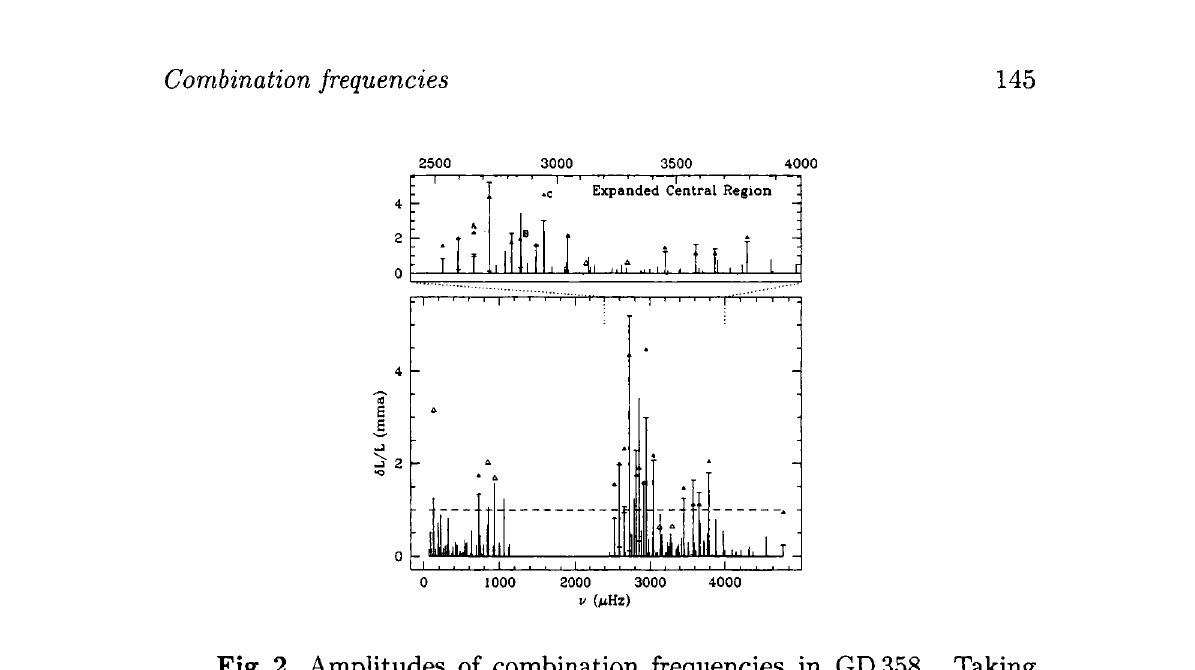
Fig. 2. Amplitudes of combination frequencies in GD 358. Taking amplitudes of gravity-modes from Winget et al. (1994), we calculated the amplitudes of combination frequencies expected from theory, shown here as vertical lines. The observed amplitudes are marked as triangles: the triangles are solid (and there is a bar on top of the vertical lines) when they lie within 0.1 % in frequency from the vertical lines (roughly the frequency resolution for this WET run); they are open if otherwise. The dashed line at amplitude of 1 mma is the approximate detection limit in this particular WET observation. The top panel expands the central region in the lower panel. The three letters (A, B and C) denote the three cases of serious discrepancy. We regard all (and consider only) g-modes as i = 1, m =